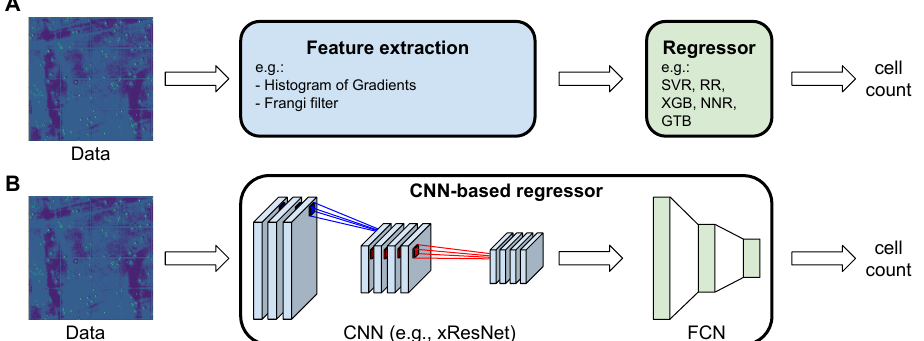
Figure 1. A schematic representation of the automatic cell counting pipeline. ( A ) A machine learning pipeline as a composition of two separate steps: (i) a feature extraction method, and (ii) a regressor. ( B ) A CNN-based regressor that is a composition of deep-learning blocks.